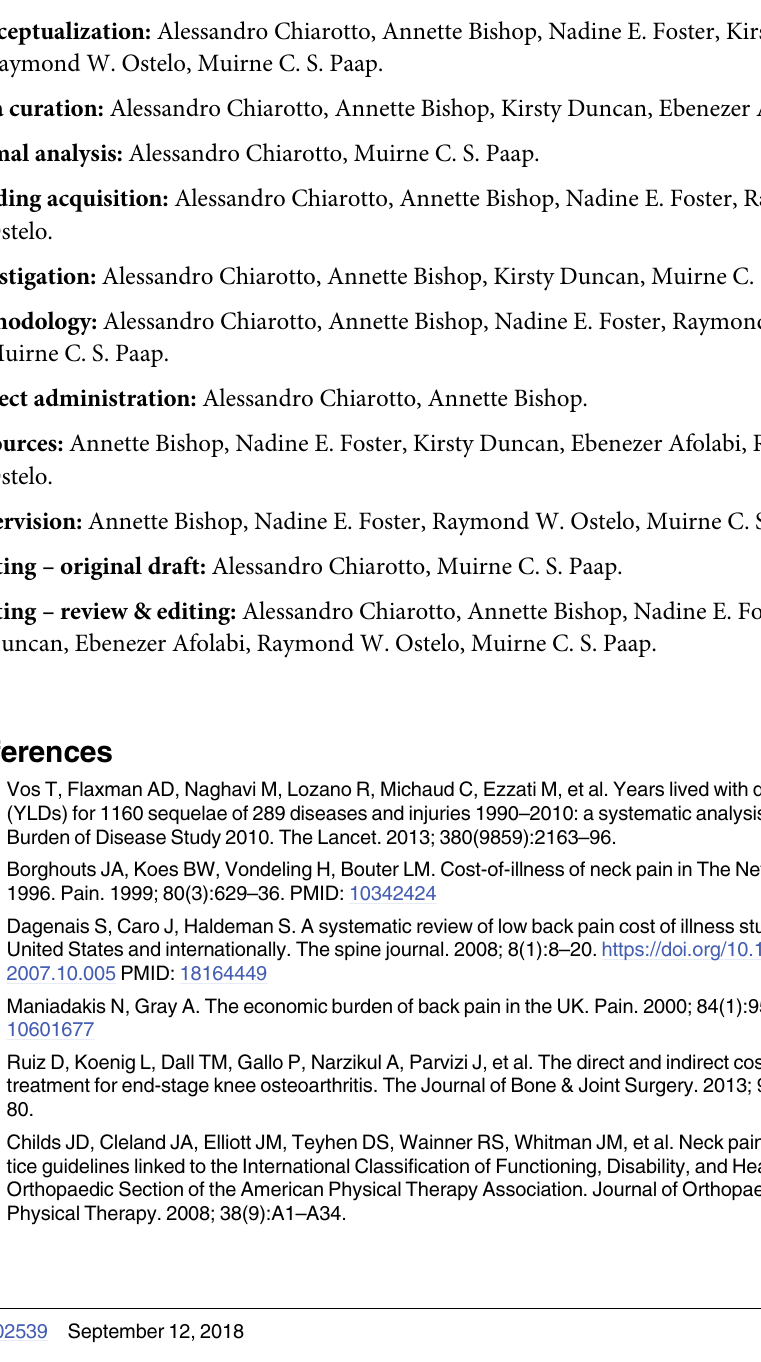
S1 Table. Polychoric correlation matrix of the biomedical scale of the Pain Attitudes and Beliefs Scale (PABS) in the BeBack data (n = 1016). S2 Table. Polychoric correlation matrix of the biomedical scale of the Pain Attitudes and Beliefs Scale (PABS) in the DABS data (n =